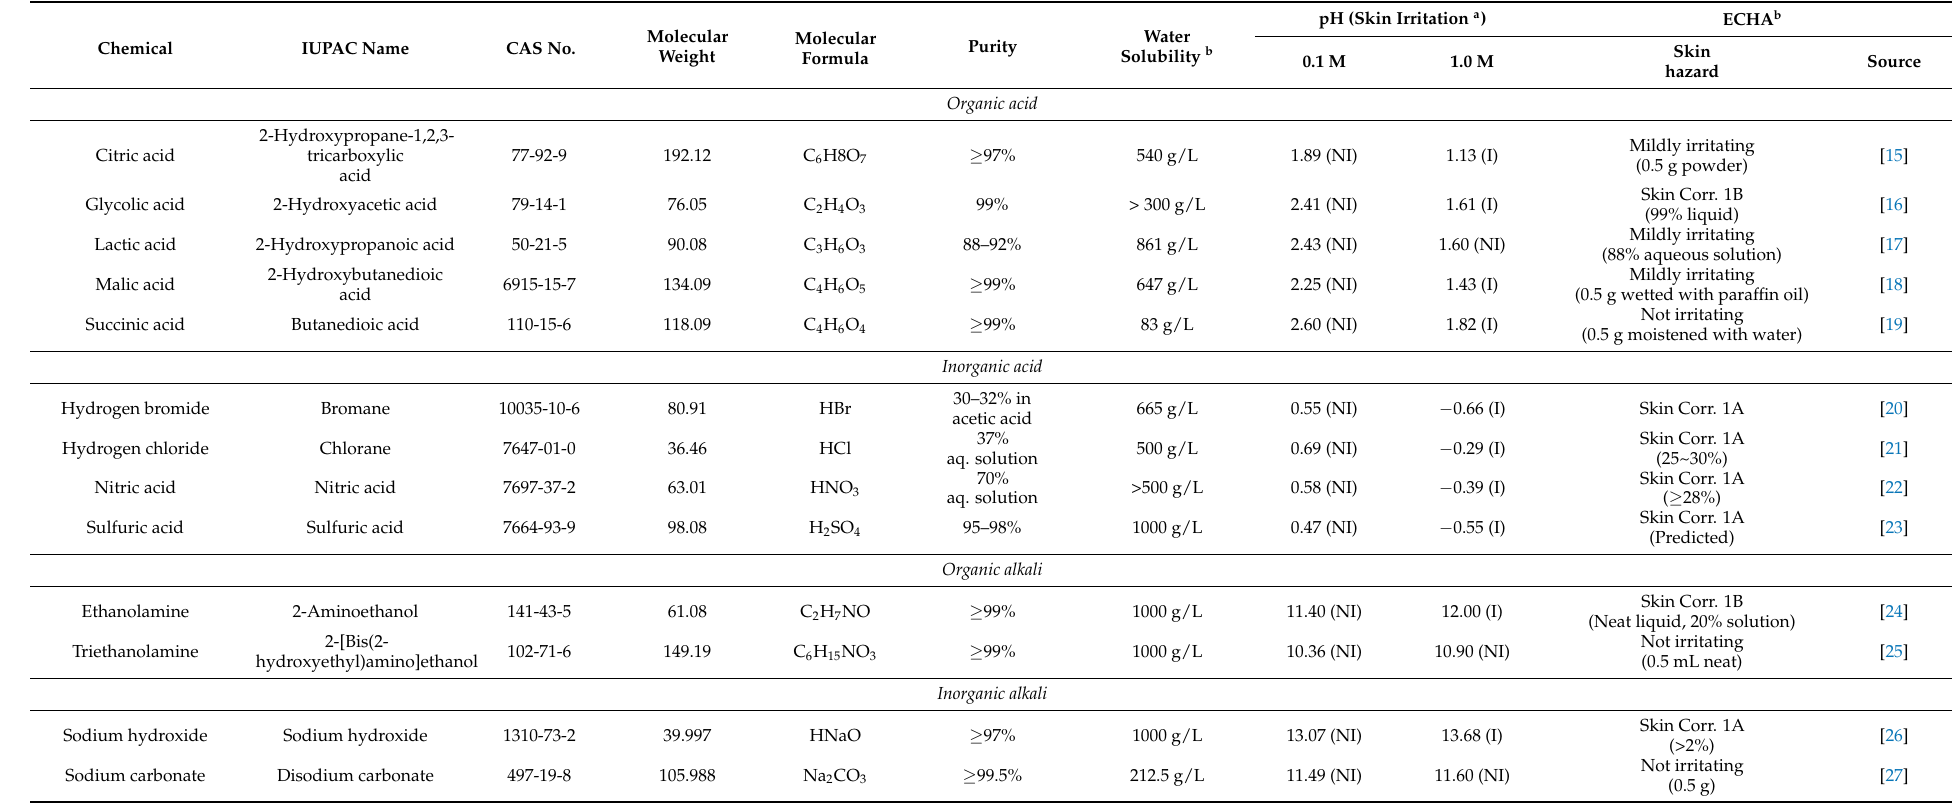
Table 1. Information on acid and alkali agents